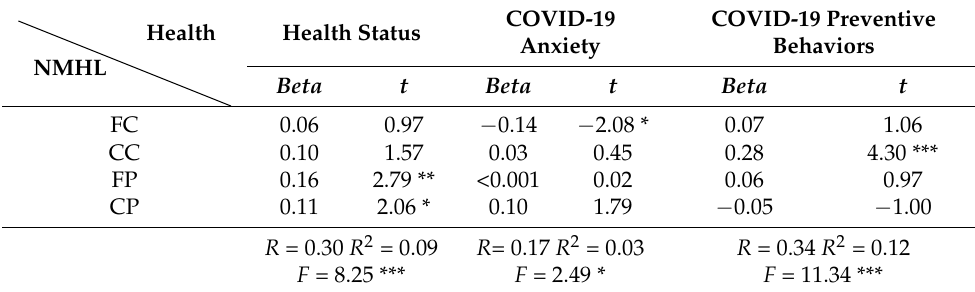
Table 3. Multiple regression analysis of COVID-19 new media health literacy and health.